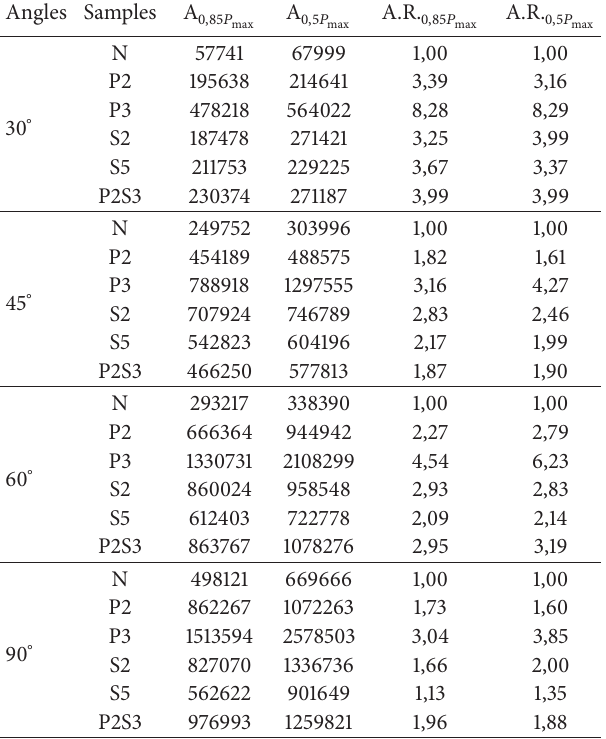
Table 6: The amounts of energy consumed by the samples.